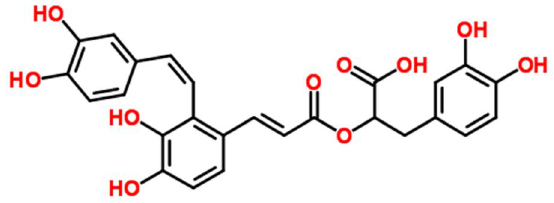
Figure 1. Chemical structure of salvianolic acid A (SAA).